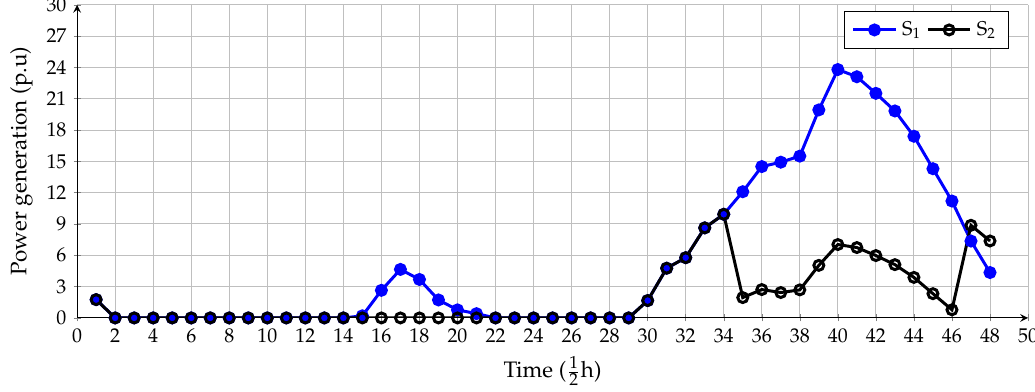
Figure 3. Power generation behavior in the slack source for both simulation